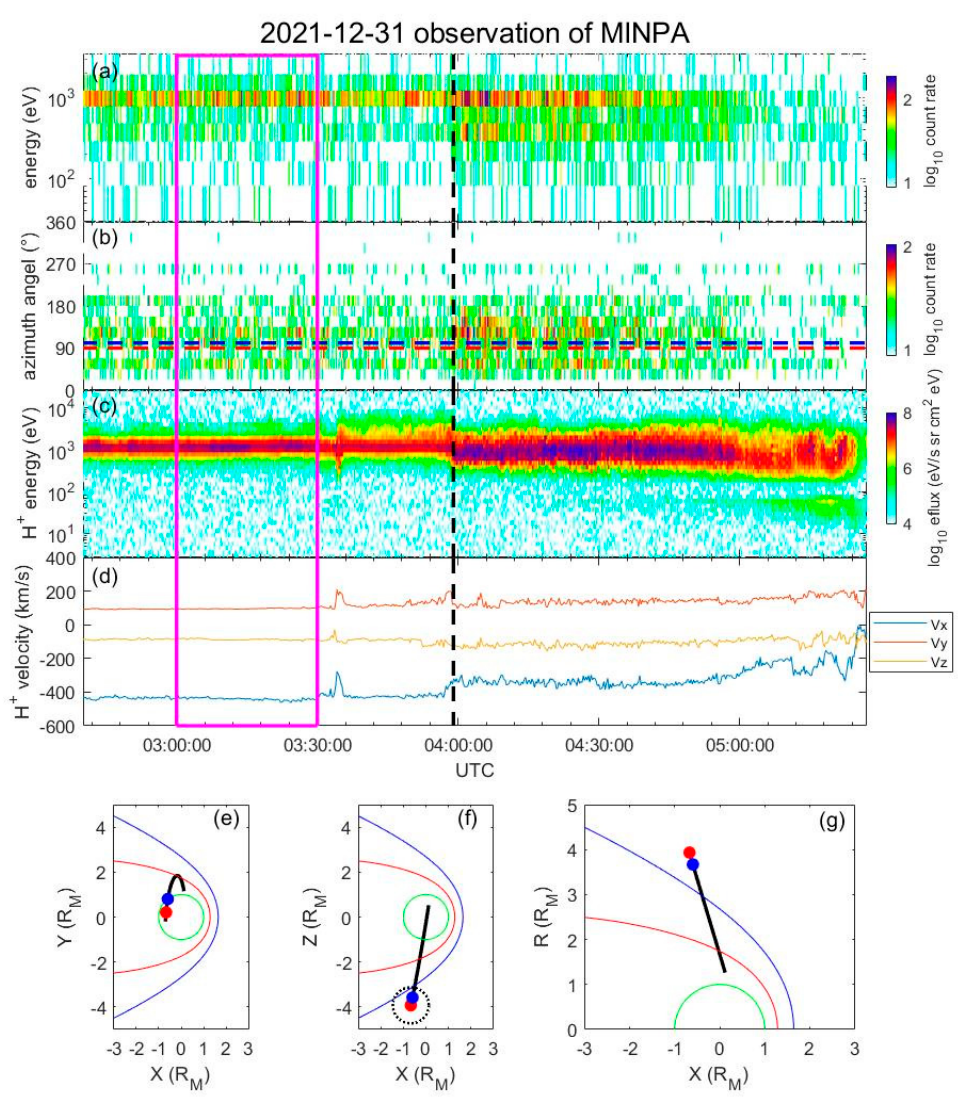
Figure 7. H-ENA and ion observation of MINPA on 31 December 2021. ( a ) Energy spectrum in H-ENA count rate; ( b ) azimuth spectrum in H-ENA count rate; ( c ) energy spectrum in H + eflux; and ( d ) H + velocity in MSO coordinates. The magenta box highlights the data used for inversion. The dashed lines mark the bow shock (vertical black); the solar direction (horizontal red); and SW incoming direction (horizontal blue). MINPA’s orbit projection in the MSO ( e ) X–Y plane; ( f ) X–Z plane; and ( g ) X–R plane, where R = (cid:3493)𝑦 (cid:2870) + 𝑧 (cid:2870) . Red and blue dots mark MINPA’s positions at 3:00 and 3:30 UTC, respectively. The lines represent the bow shock (blue); magnetic pileup boundary (MPB) (red); the planet (green); and the orbit of Tianwen-1 (black). The black dotted circle represents the FOV of MINPA in the X–Z plane.